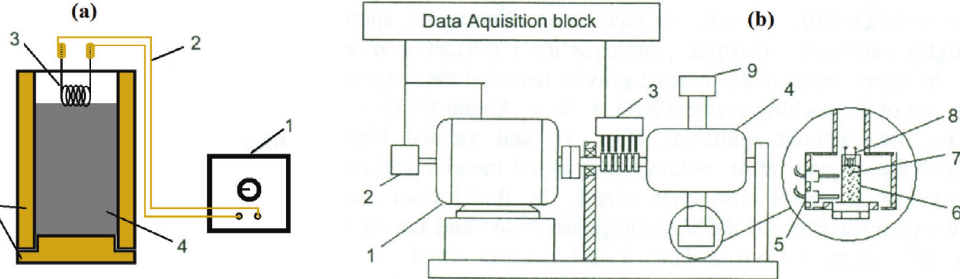
Fig. 1: The schematic views of SHS experimental setup. a) batch-type system: (1) power supply, (2) Cu cable, (3) igniter, (4) green mixture, (5) Cu crucible; b) centrifugal system: (1) electrical motor, (2) tachometer, (3) collector, (4) rotor, (5) photodiodes, (6) C/SiC crucible,